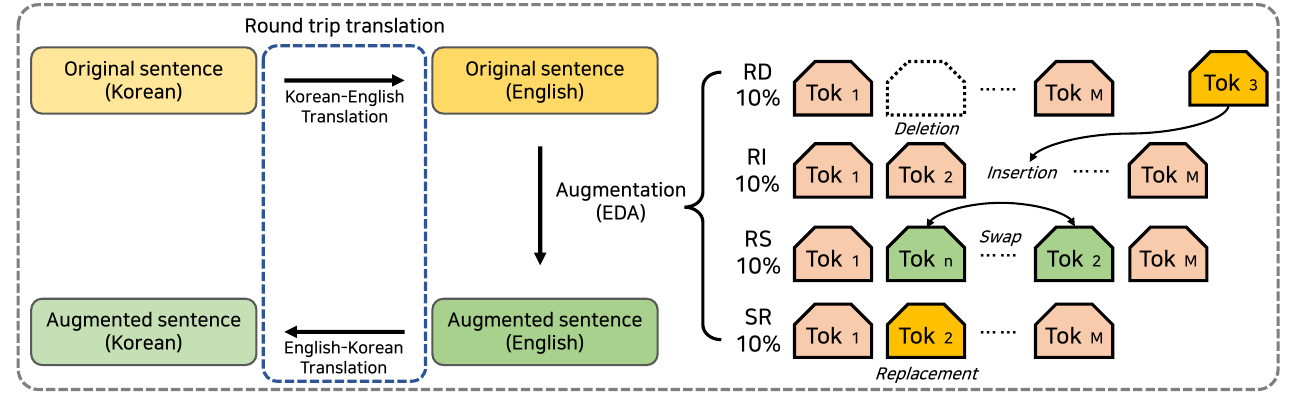
Figure 2. An overview of the RTT process with four EDA strategies, which is applied as SR, RI, RS, and RD by 10%,